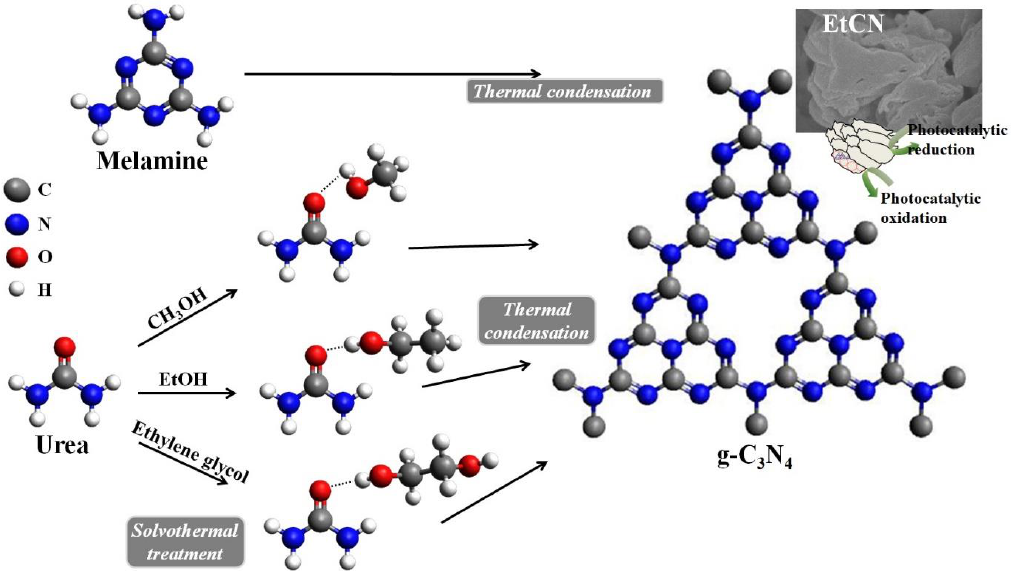
Figure 7. Proposed mechanism for synthesis of g-C 3 N 4 using melamine or solvent-treated urea as raw